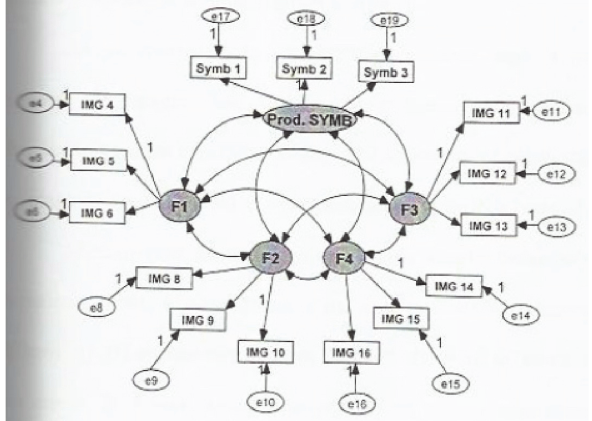
<Figure 6> Imagination Scale’s Construct Validity Testing: Imagination Types and Product Symbolism